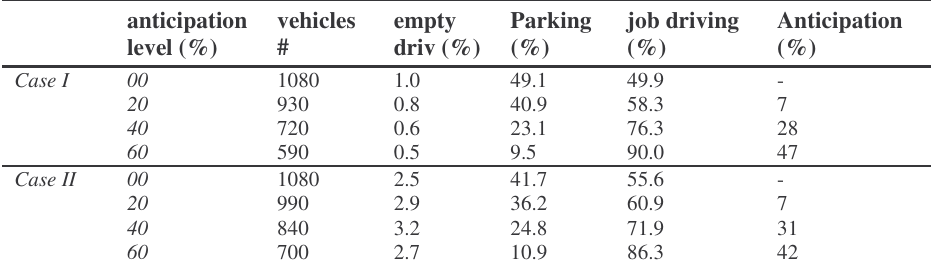
Table 5. Number of required vehicles and average